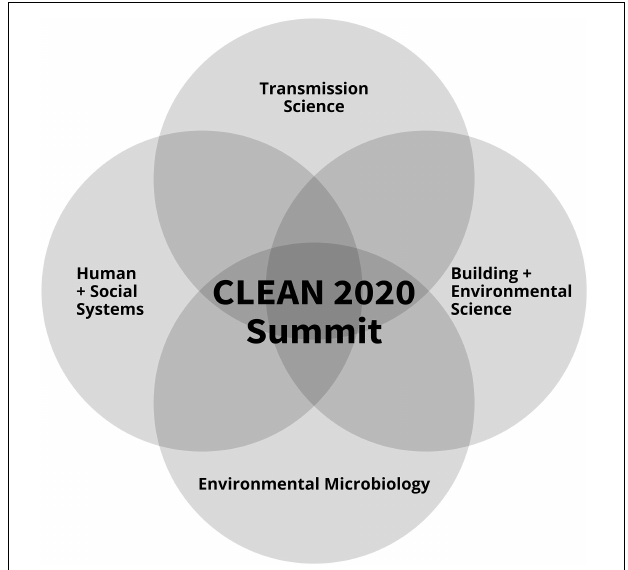
FIGURE 1 | Science Communities Represented in the CLEAN 2020 Summit.